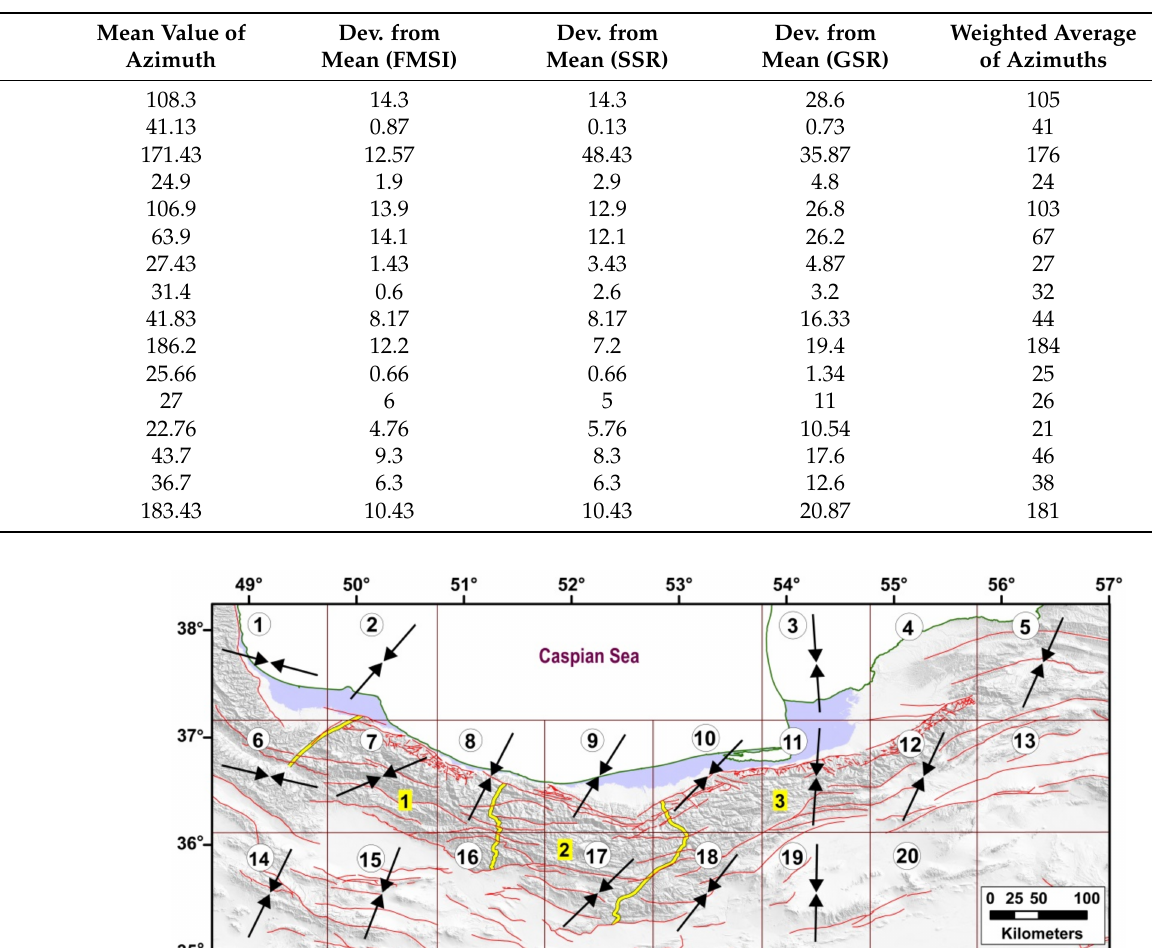
Table 7. The weighted average of the maximum horizontal compression axes obtained from the FMSI, SSR, and GSR for the study area.